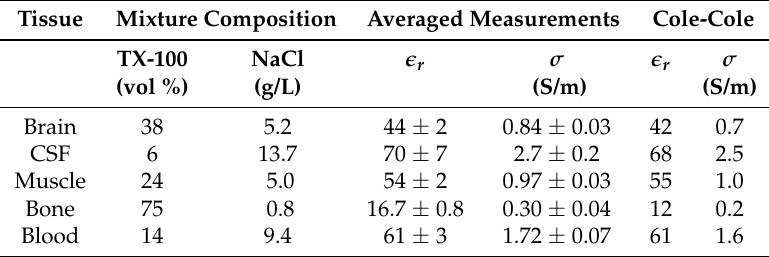
Table 2. Composition and properties of head TMMs at 1 GHz and 37 ◦ C versus the values inferred from Cole–Cole